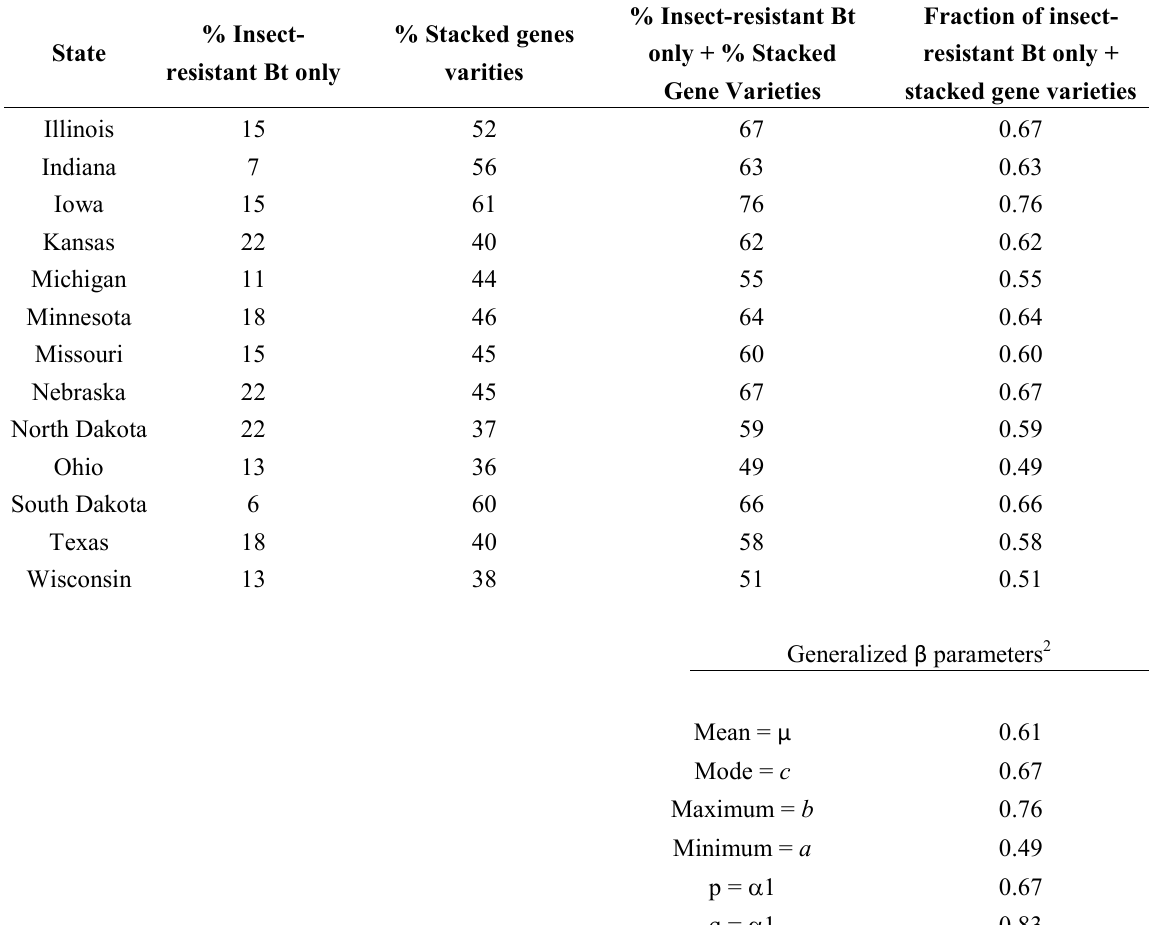
Table 4. Percentage of insect-resistant Bacillucs thuringiensis (Bt) and stacked gene varieties (Bt plus herbicide resistance) in US 2010 corn varieties used to estimate Bt use fractions (BUF) in grower-finisher pig diets 1